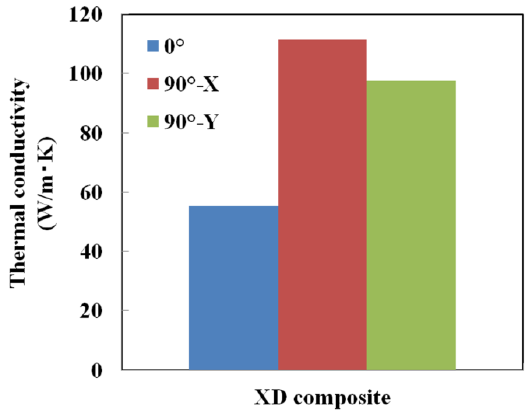
Figure 17. Thermal conductivity of Cu plated C/Al SLM composite fabricated with XD scanning pattern.